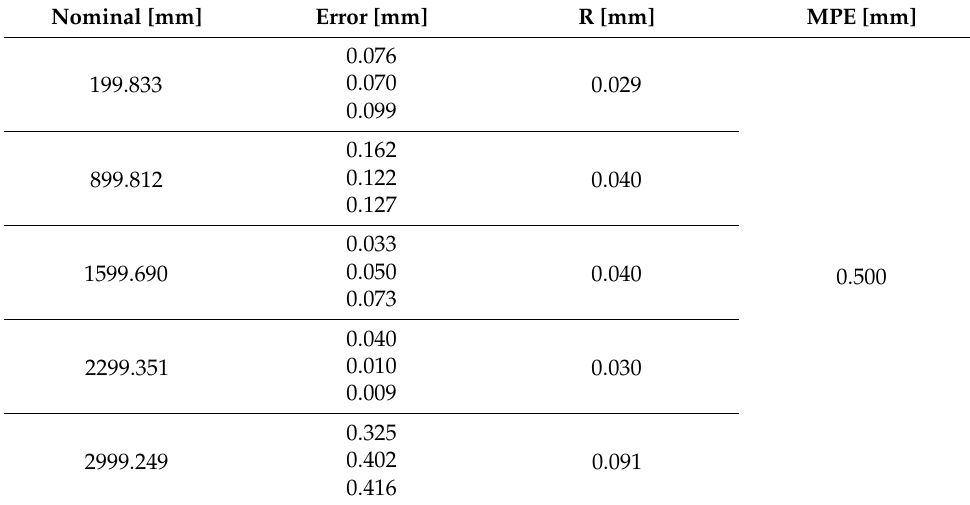
Table 2. Measurement errors of the X-axis (horizontal